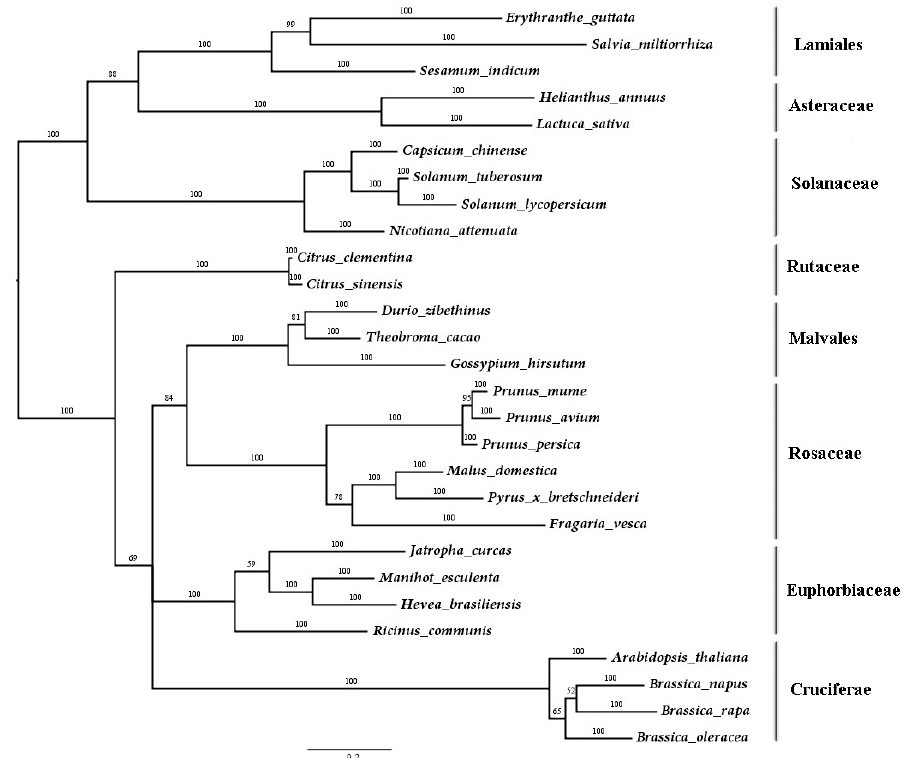
Figure 2. Phylogenetic tree based on JMT from S. miltiorrhiza and other species. The tree was constructed using Bayesian inference implemented in MrBayes, based on the amino-acid sequences of SmJMT and other species of JMTs under the model of JTT + I + G. The species taxonomy is indicated on the tree.